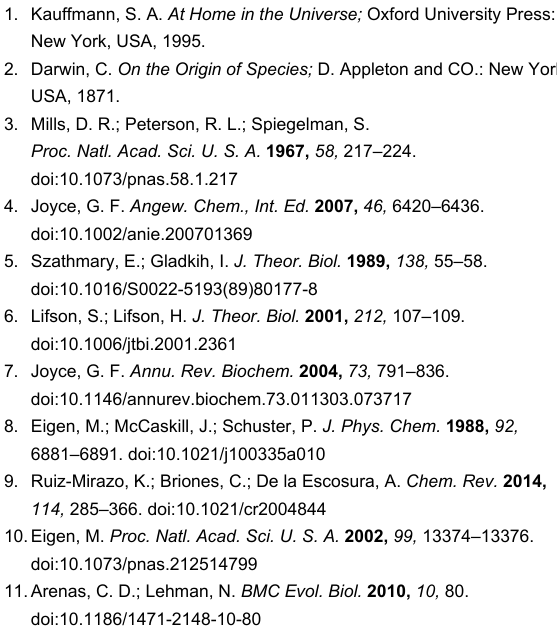
replicators. Also mechanical forces may be utilized to break up larger assemblies of self-replicating molecules and liberate the assembly edges or fiber ends that promote